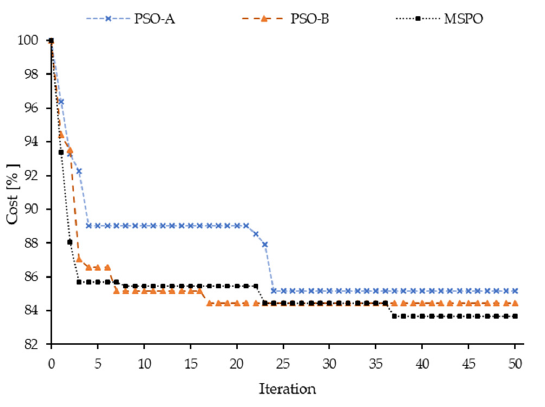
Figure 9. Optimization trend during a run time.